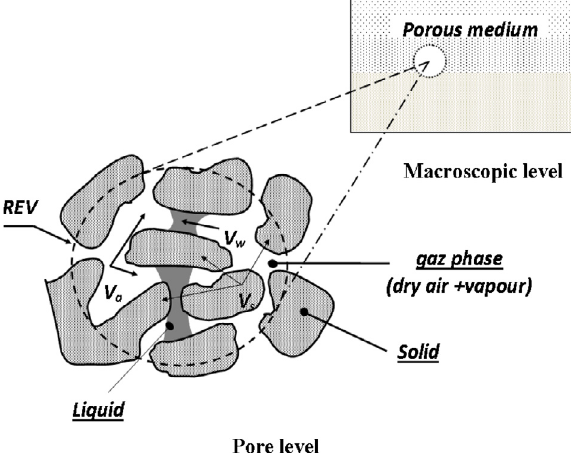
Figure 1. Illustration of representative volume element (REV).